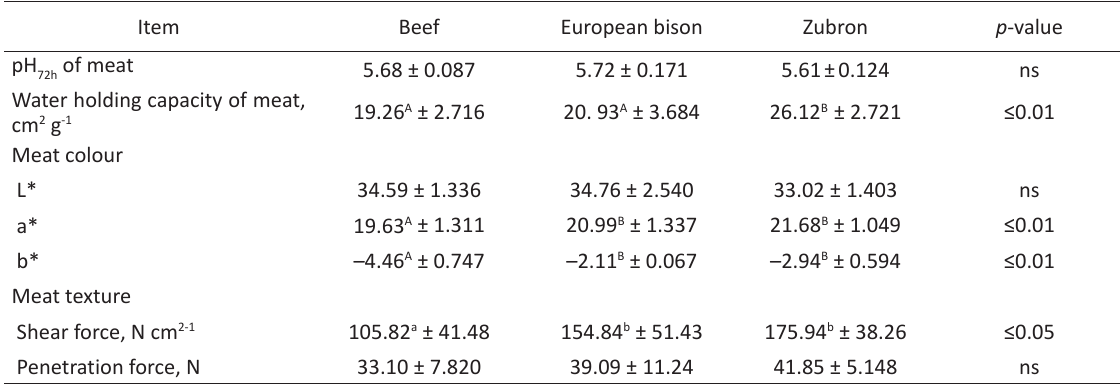
Table 4. Selected parameters of meat quality Item